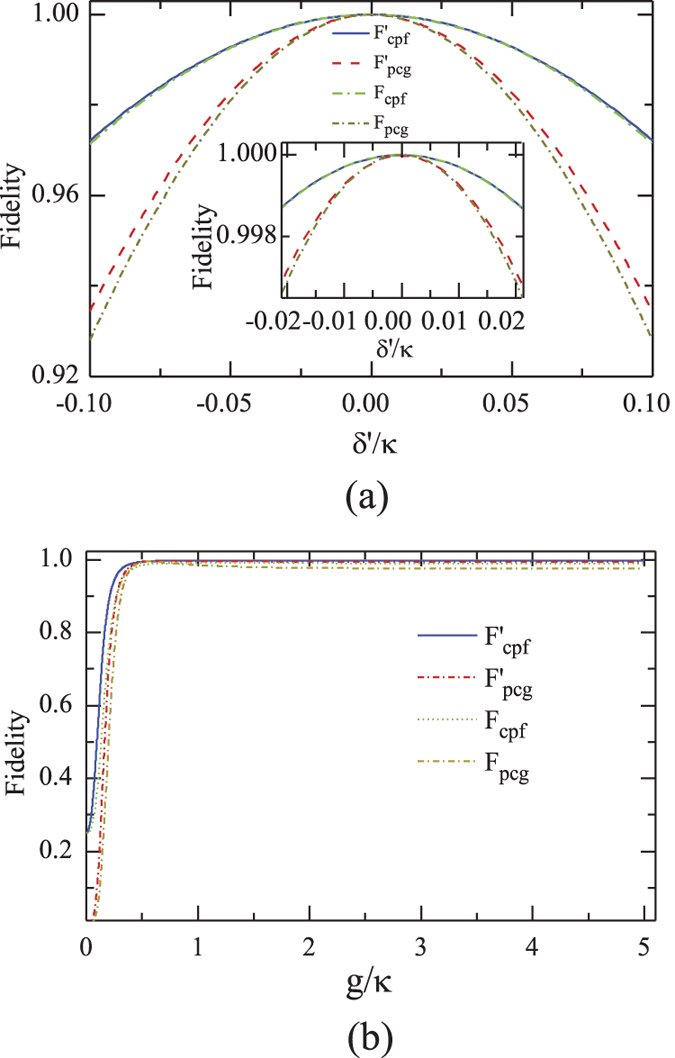
(a) Fidelities of our CPF gate and PCG vs the scaled detuning.  and  is performed with the scaled coupling rate g/κ = 2.0283 and γ/κ = 0.0566, Fcpf and Fpcg are performed with the scaled coupling rate g/κ = 4.0566 and γ/κ = 0.056653. (b) Fidelities of our CPF gate and PCG gate vs the scaled coupling rate.  and  are performed with the scaled detuning δ′/κ = 0.0283 and γ/κ = 0.0566, Fcpf and Fpcg is performed with δ′/κ = γ/κ = 0.0566.